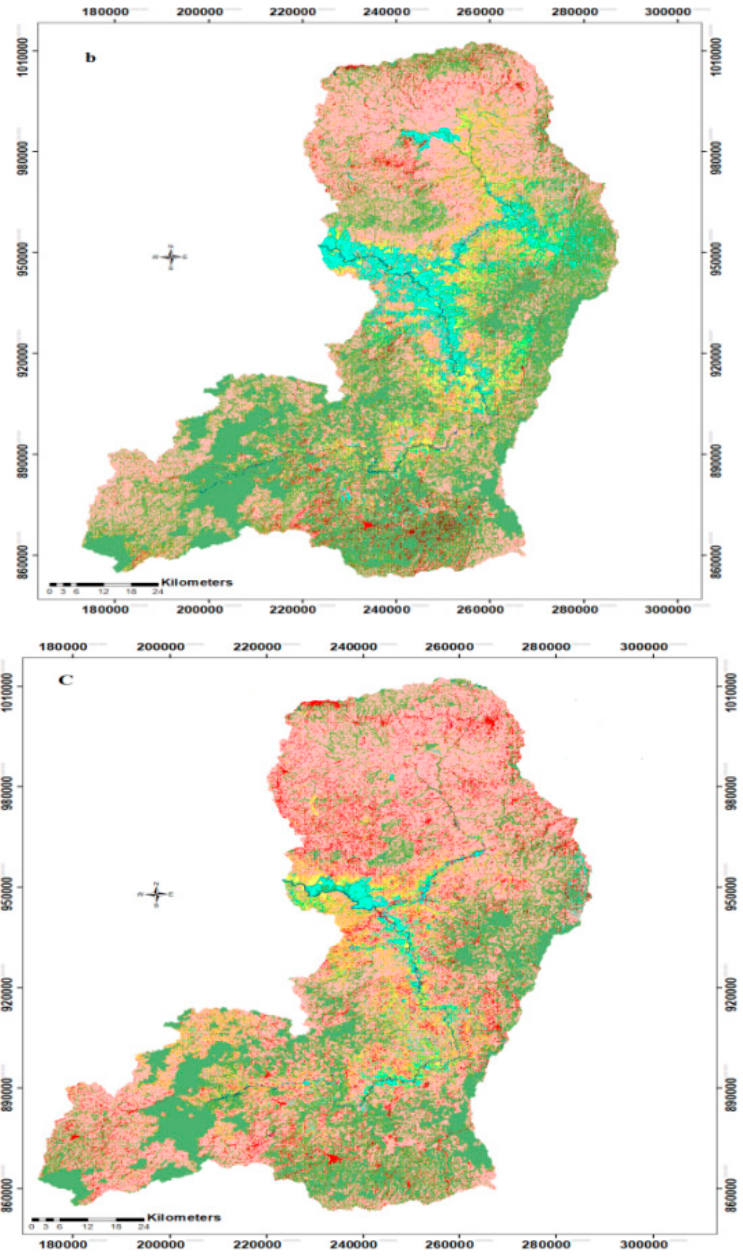
Figure 4. Major LULC types in the Didessa river basin in the years 1986 ( a ), 2001( b ) and 2015 ( c